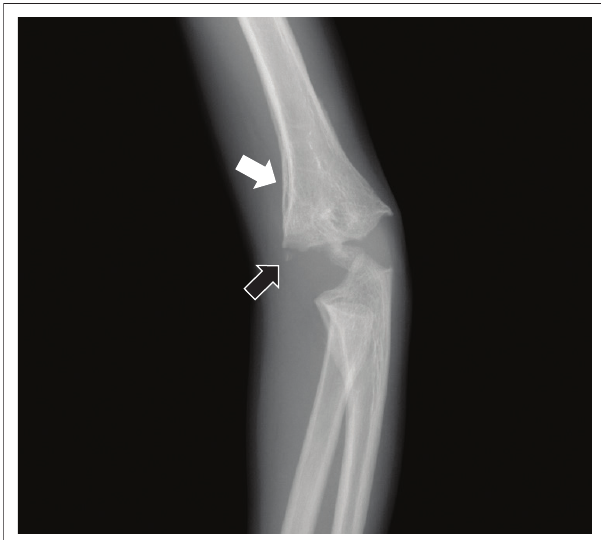
FIGURE 3: Three-year-old male with a medial distal humerus metaphyseal corner fracture (black arrow) and a periosteal reaction medially (white arrow) on an AP view of the left humerus. The metaphyseal corner fracture is a high- specificity fracture location for non-accidental injury (NAI).